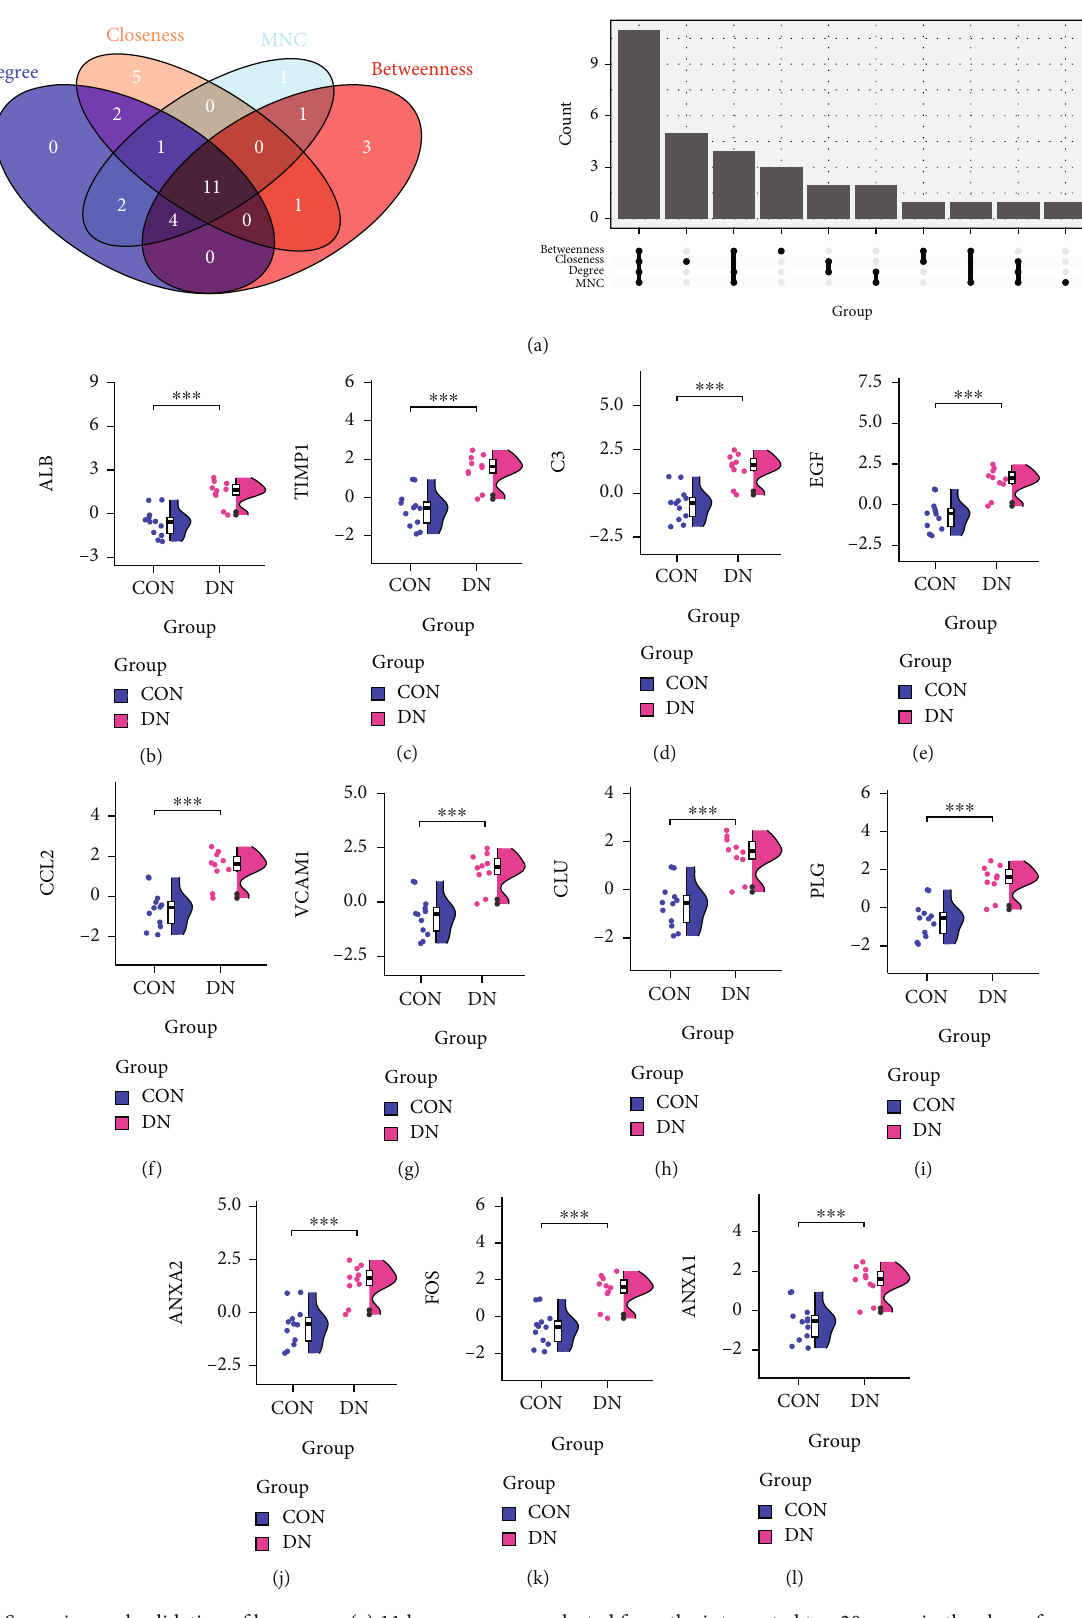
Figure 5: Screening and validation of key genes. (a) 11 key genes were selected from the intersected top 20 genes in the above four screening methods. Validation of expression levels of hub genes from the GSE30529 dataset. 11 key genes showed the similar upregulation trend: (b) ALB, (c) TIMP1, (d) C3, (e) EGF, (f) CCL2, (g) VCAM1, (h) CLU, (i) PLG, (j) ANXA2, (k) FOS, and (l)